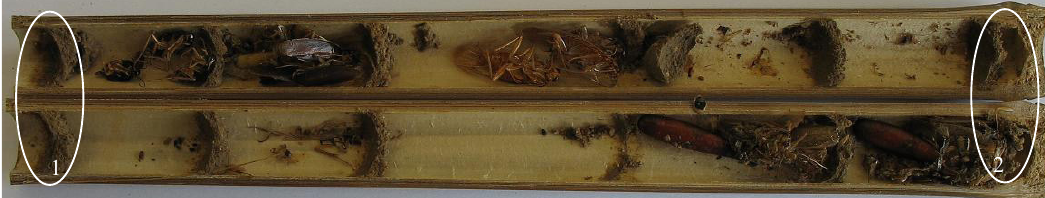
Fig 3 . P . denticulatum nest. Closure plug (1) and deep plug (2) are shown.